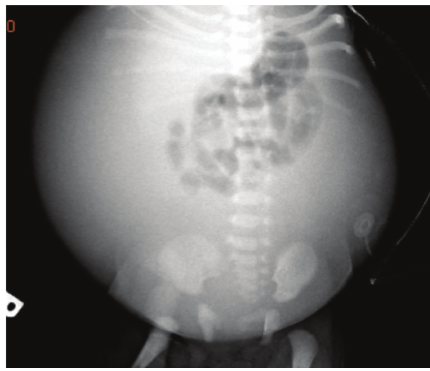
Figure 2: Abdominal X-ray, day of life 1: distended abdomen with centralization of bowel loops showing massive ascites.